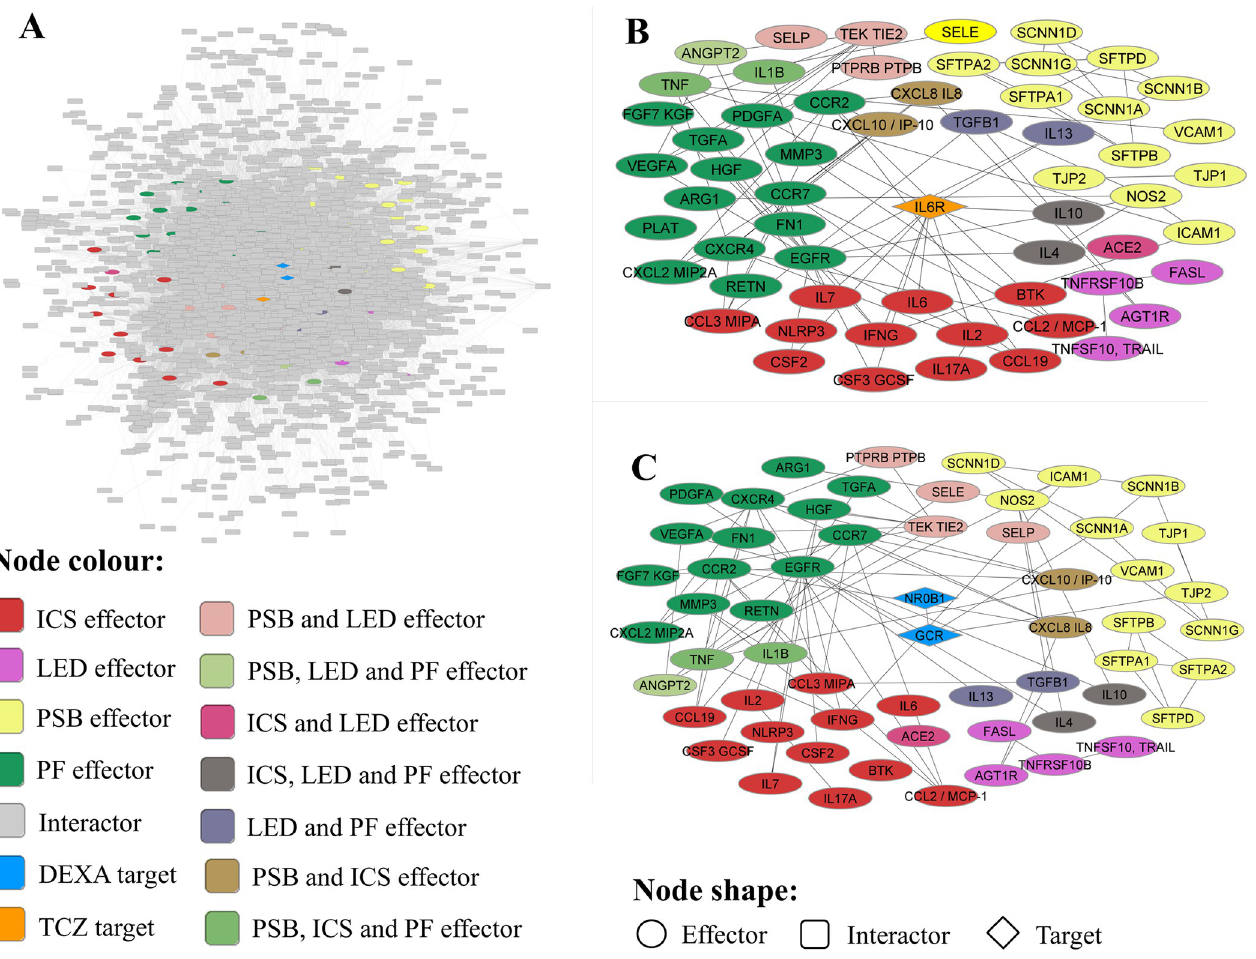
Fig 2. COVID-19 evoked ARDS interactome. Human protein networks around COVID-19 evoked ARDS molecular pathophysiology considering all disease effectors and their direct interactors. General overview (A) and centred on the relationship of COVID-19 evoked ARDS effectors to tocilizumab (B) and dexamethasone (C) drug targets. Image created with Cytoscape 3.7.0 [56]. DEXA, dexamethasone; ICS, Inflammatory cytokine storm; LED, Lung epithelial damage; PF, Pulmonary fibrosis; PSB, Pneumonia and shortness of breath; TCZ, tocilizumab.